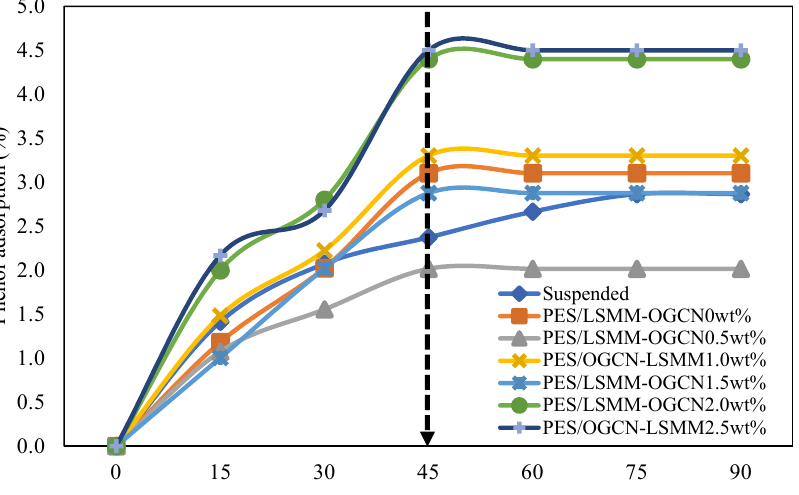
Figure 8. Phenol adsorption test using PES/LSMM-OGCN membranes.